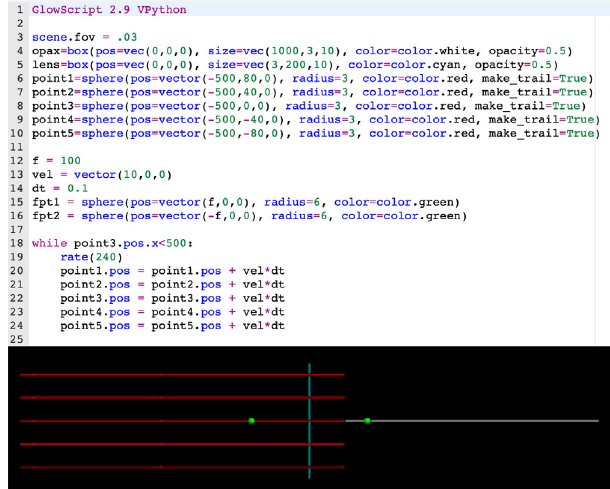
FIG. 1. Starter code and snapshot of the dynamic visualization for Mr. Buford ’ s converging lens activity. Lines 4 – 10 of the code initialize the lens, x axis, and light particles. Lines 12 – 16 initialize the focal points, give the particles a velocity, and define a time step for each frame of the animation. Lines 18 – 24 iteratively move the particles using their velocity and the time step. The snapshot of the visualization shows that the particles pass through the lens in a straight line, indicating that the program does not fully model the physics properly.